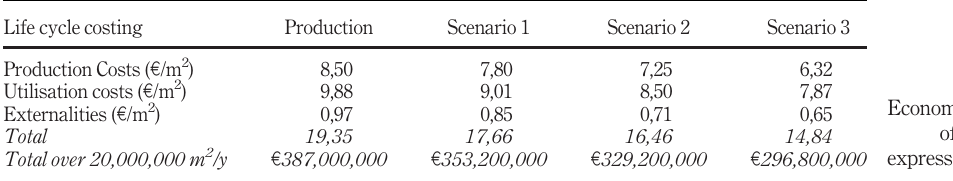
of externalities expressed in euro/m